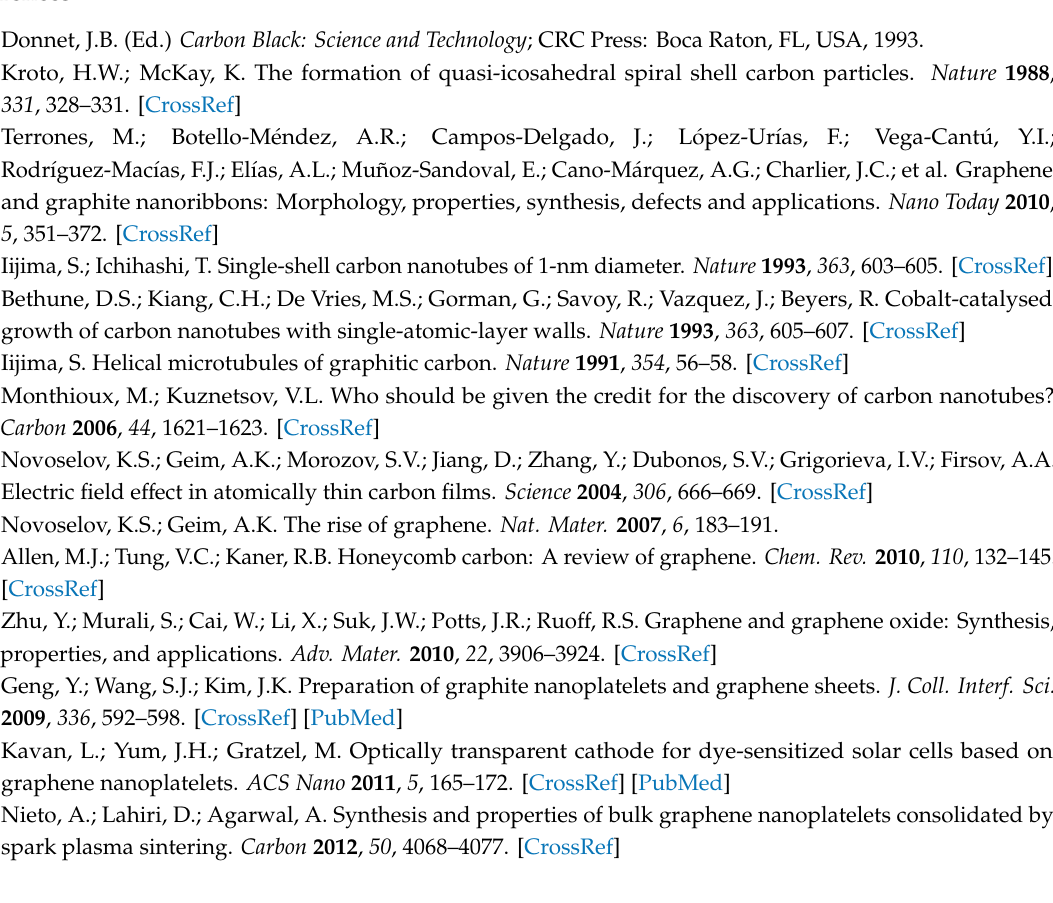
Figure S2: Raman spectra of CNTs and CNT-SP, Figure S3: FT-IR spectra of PyCs, Figure S4. Mechanism for the interaction of graphene layers with pyrrole compounds, Table S1: Hansen solubility parameters for the selected solvents, Figures S6–S10. Dispersions of the CNT-PyC adducts in di ff erent solvents, Table S2: Aqueous dispersions of CNT: based on CNT-SP and Carbobyk 9810, Figure S12. TEM and HRTEM micrographs of Carbobyk 9810 MWCNT water-based dispersion. Figure S13. WAXD pattern of Carbobyk 9810 dried dispersion, Figure S14 Coating layers of